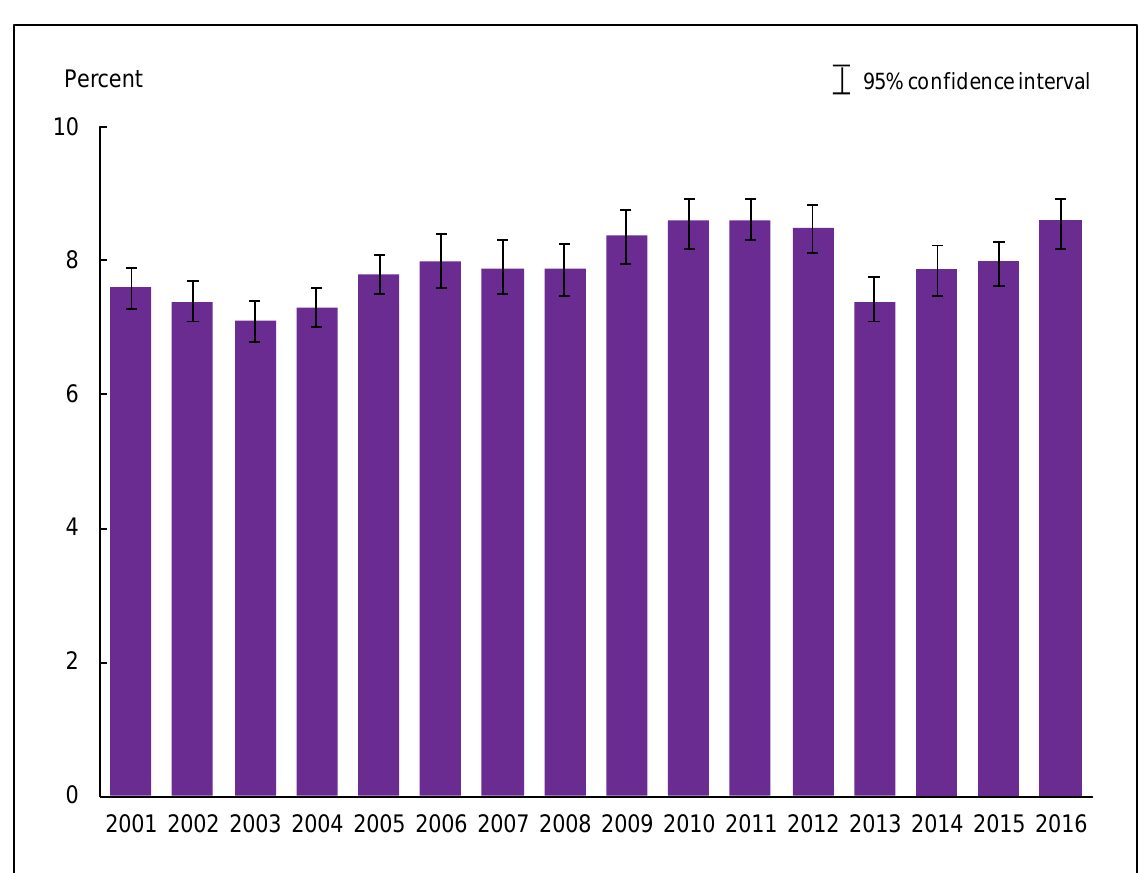
Figure 15.4. Prevalence of current asthma among persons of all ages: United States,